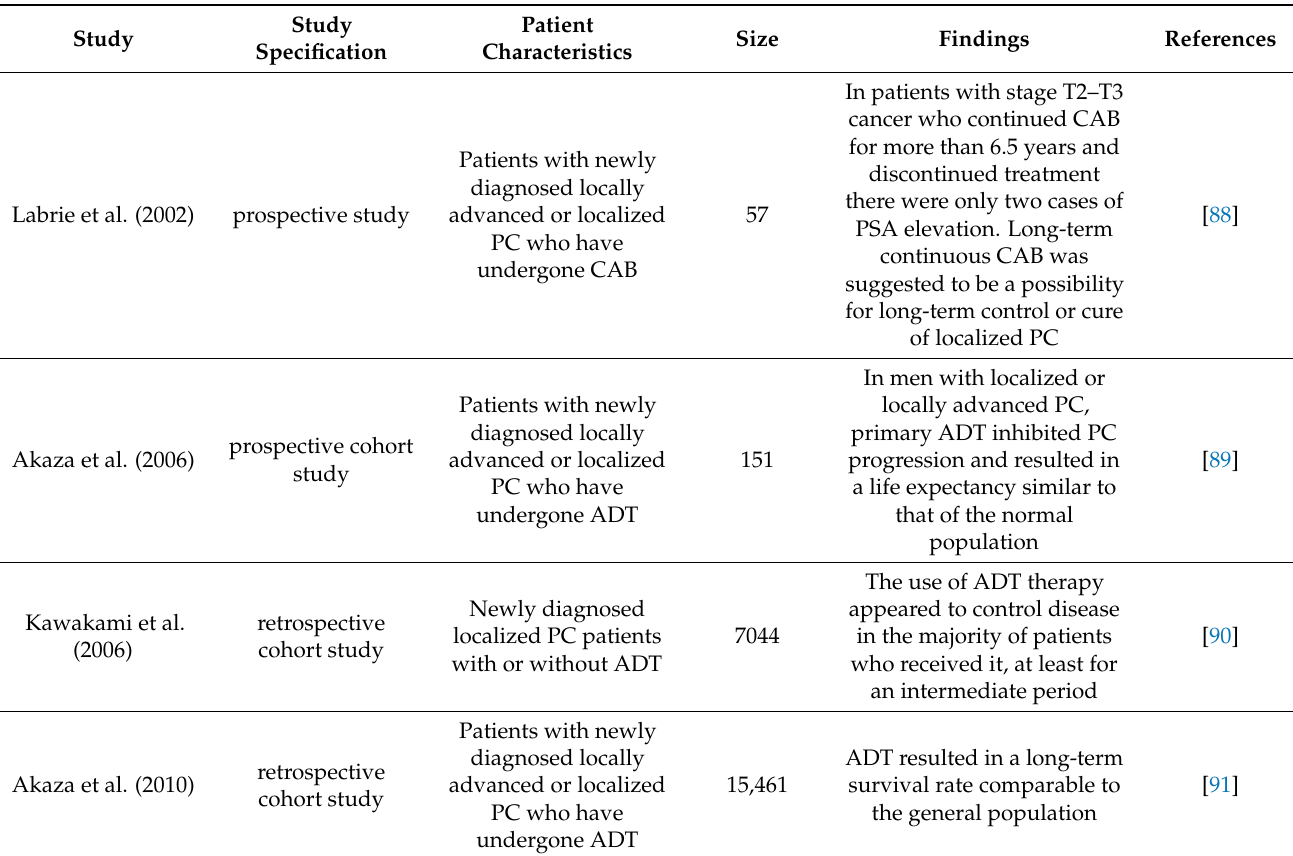
Table 3. Positive data of ADT for high-risk localized and locally advanced prostate